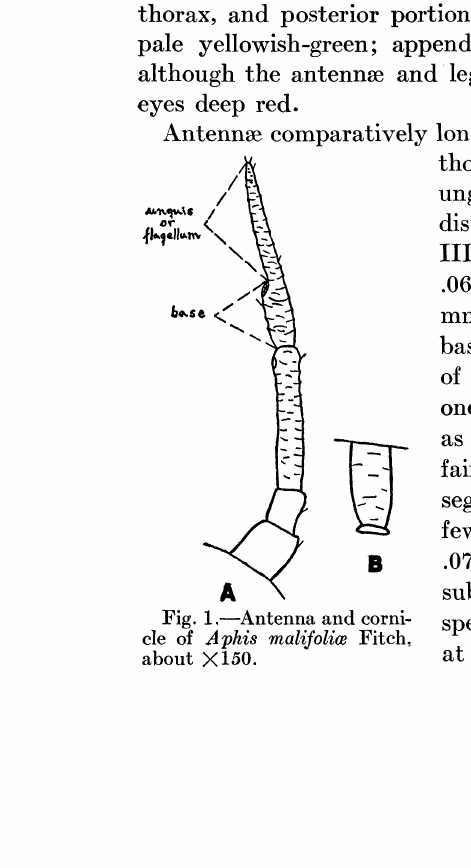
Fig. 1,uAntenna and corni- cle of Aphis malifoliee Fitch, about X